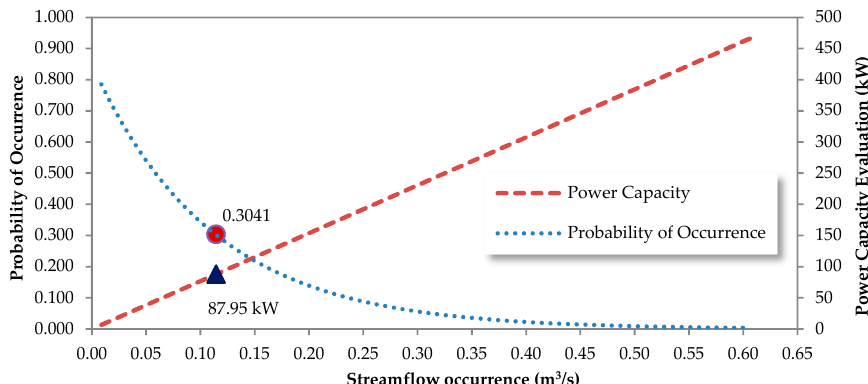
Figure 11. Relationship between probability of occurrence and power capacity evaluation based on the first phase of the algorithm (Figure 9) in 200 classes.